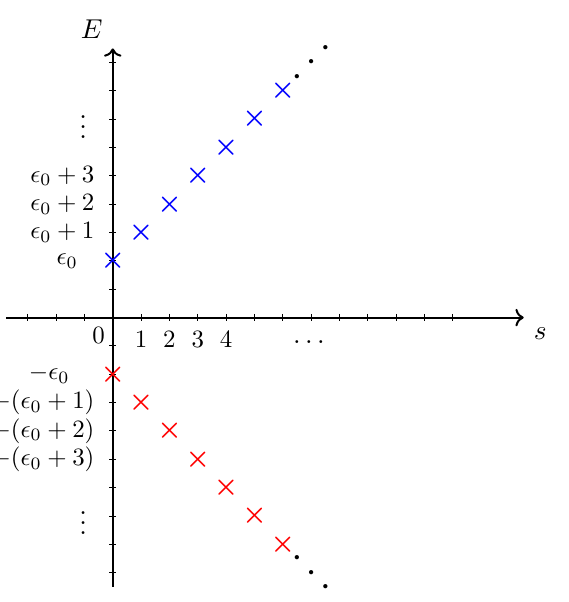
Figure 1 . Weight diagram of the scalar singleton, or Rac (blue crosses) and of the scalar anti- singleton, or anti-Rac (red